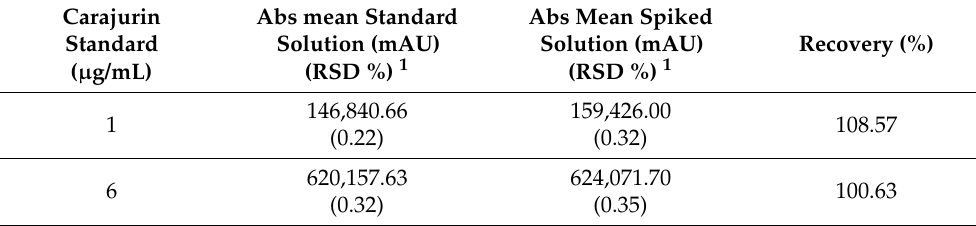
Table 7. Results for recovery test of the new analytical method.